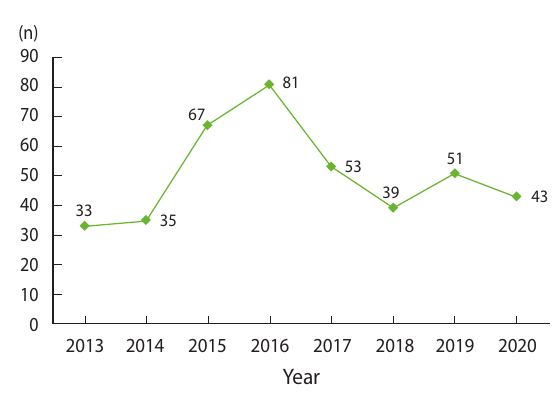
Figure 2. Malignancies incidence over the study